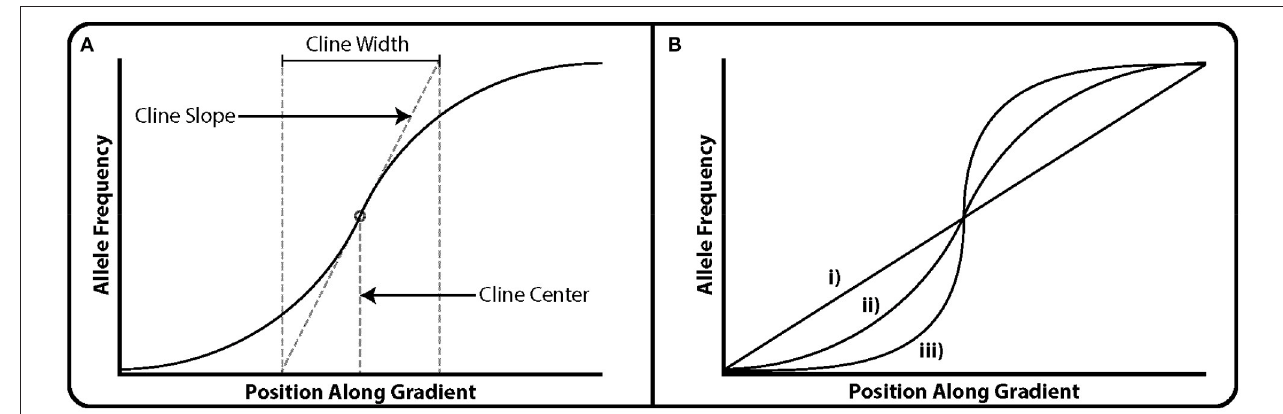
FIGURE 1 | An illustration of clines. X-axes correspond to position along geographic transects (ecological gradient) or hybrid indexes (genomic gradient) in the case of genomic cline analyses. (A) Illustration of the three parameters typically estimated in the use of geographic of genomic cline analysis. Cline slope is the estimate of the rate of allele frequency turnover at the steepest point in the cline. In genomic cline analysis this corresponds to the rate of introgression. Cline center corresponds to the point along the geographic transect or hybrid index at which allele frequency turnover is greatest. Cline width corresponds to the region along the gradient at which it’s influence on allele frequency is greatest. (B) Three examples of clines. (i) A transect along which no selection appears to be acting, or the effects of gene flow are such that changes in allele frequency are purely a function of distance. In the case of genomic cline analyses, the loci under consideration appears to be favored equally in both parental taxa. (ii) A modest cline in which the allele favored by selection changes along the gradient. Given its shallower slope, selection may either be weaker, gene flow stronger (in the case of geographic transects) or the ecotone separating ends of the transect greater. (iii) A steep cline, often called a step cline. In the case of geographic clines, these are formed either by strong selection acting in favor of one allele along a sudden ecotone, or extremely limited gene flow along said ecotone. In the case of genomic clines, this may be due to heterozygote disadvantage, as in the case of reinforcement.